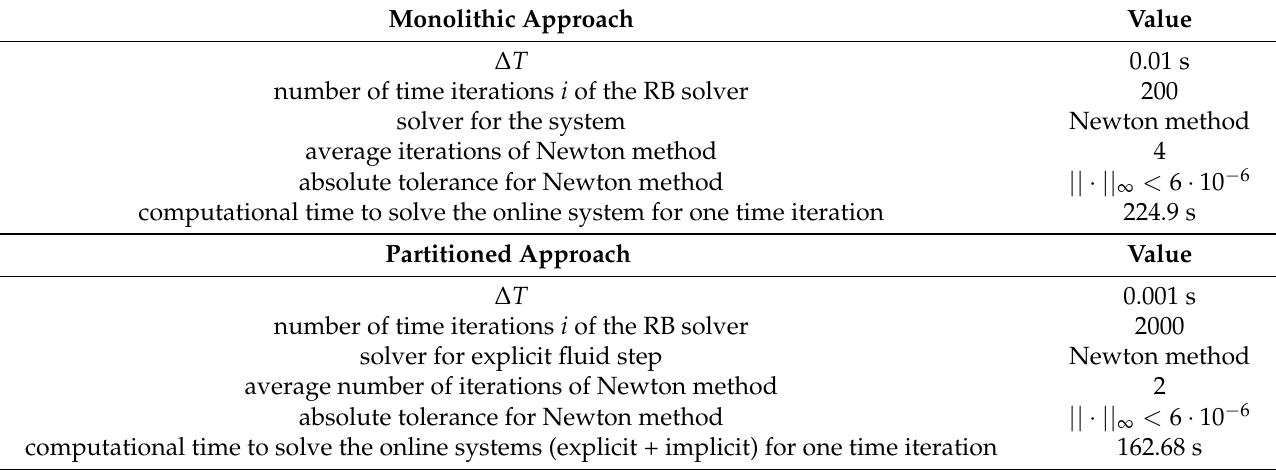
Table 4. A comparison between the two